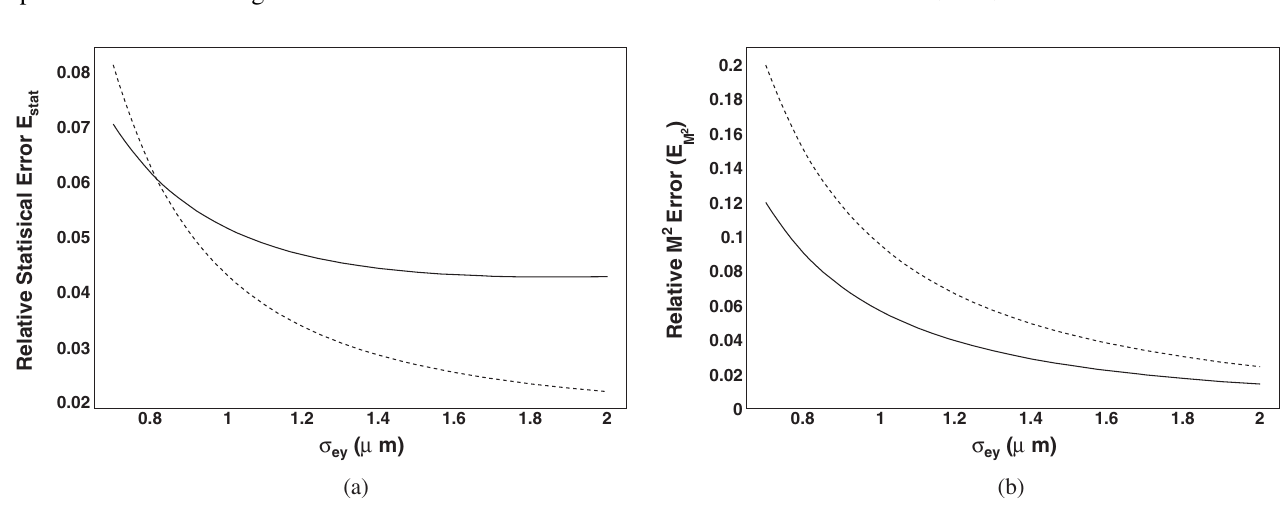
FIG. 14. Relative errors as a function of electron vertical Gaussian spot size, (cid:2) wavelength 532 nm, operating in the TM f has been chosen to optimize the statistical error. (a) statistical error E # arising from a 5% error in the value of the laser M 2